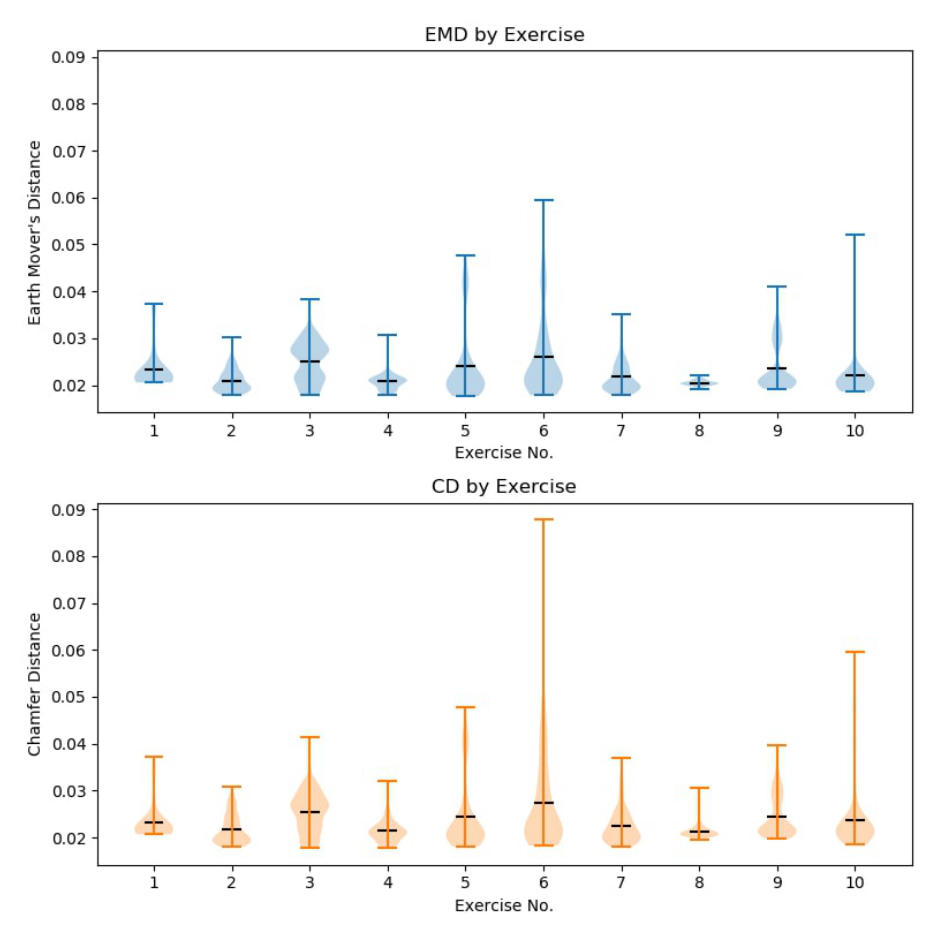
Figure 9. Reconstruction quality breakdown by the recorded motion capture exercise.